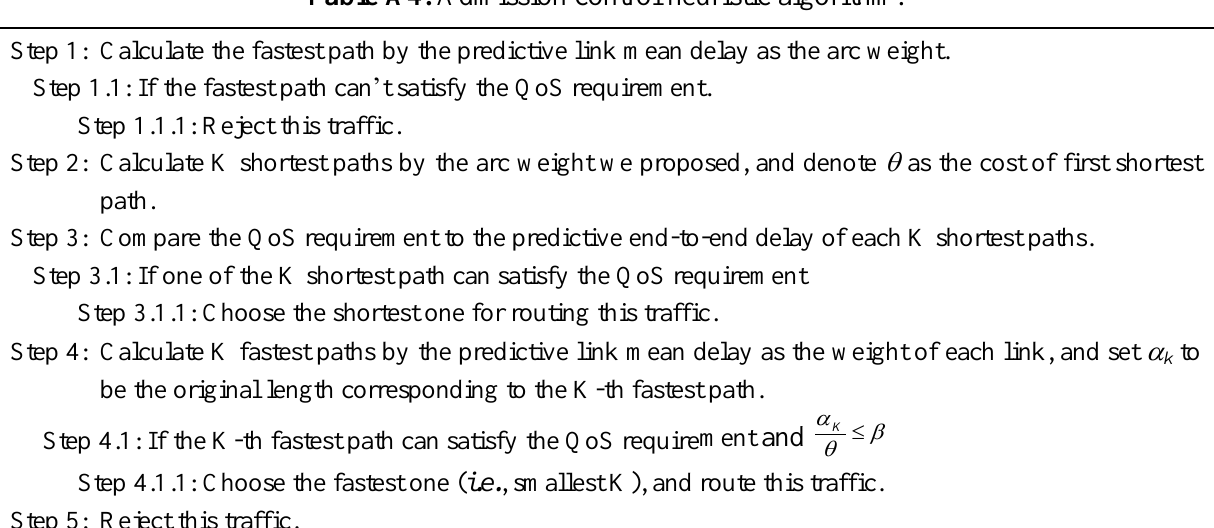
Table A4. Admission control heuristic